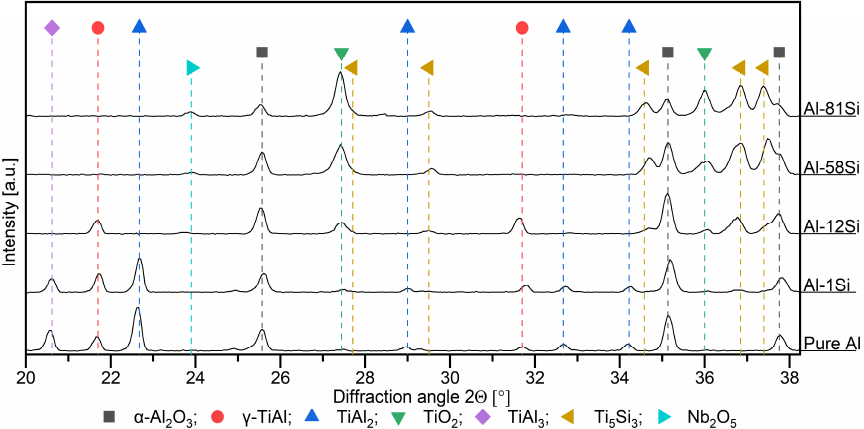
Figure 9. XRD diffractograms of the different Al-Si coatings on a TNB-V2 alloy after cyclic oxidation tests up to 1000 cycles at 900 °C in lab air.